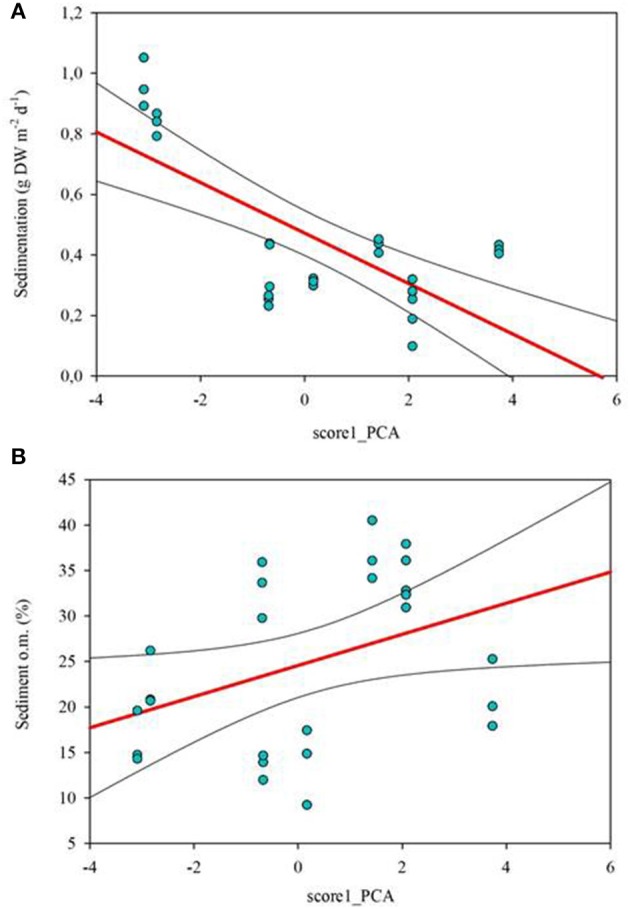
Correlations between physicochemical variation of the water column measured by PC1 score from Figure 3 and sedimentation rates [g dry weight (DW) m−2 d−1; (A)] and sediment organic content (in %; B). PC1 explained 39.9% of the variability of the samples and it was mainly accounted by sub-superficial percentage of light in the meadow (Im), water column Chl-a (W_Chl-a) and total phosphorus. Correlations are given as Spearman's rank-order correlations (rho) in Table 3. Significant values are set at p < 0.05.